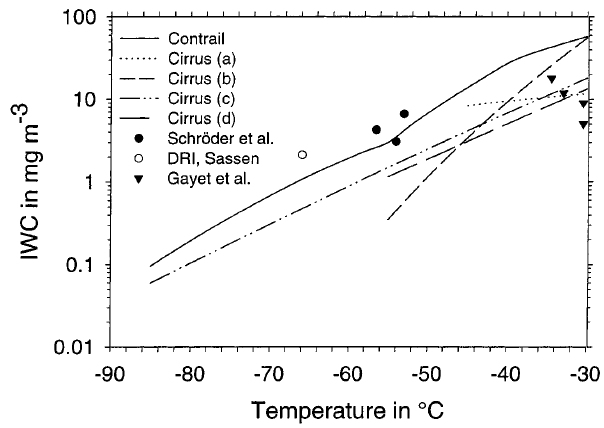
Fig. 1. Ice water content (IWC) versus ambient temperature. The solid curve is the proposed contrail IWC model of this study. The various dashed curves represent fits to IWC values observed in cirrus over ( a ) Wisconsin, ( b ) various parts of continental USA, ( c ) tropical cirrus (Heymsfield, 1993) and a fit ( d ) (Stephens et al. , 1990; Sinha and Slingo, 1994) for midlatitude cirrus data of Heymsfield and Platt (1984). The symbols denote individual IWC data measured in aged contrail cirrus by Gayet et al. (1996), by the Desert Research Institute (see Sassen, 1997), and Schro¨ der et al. (1998)